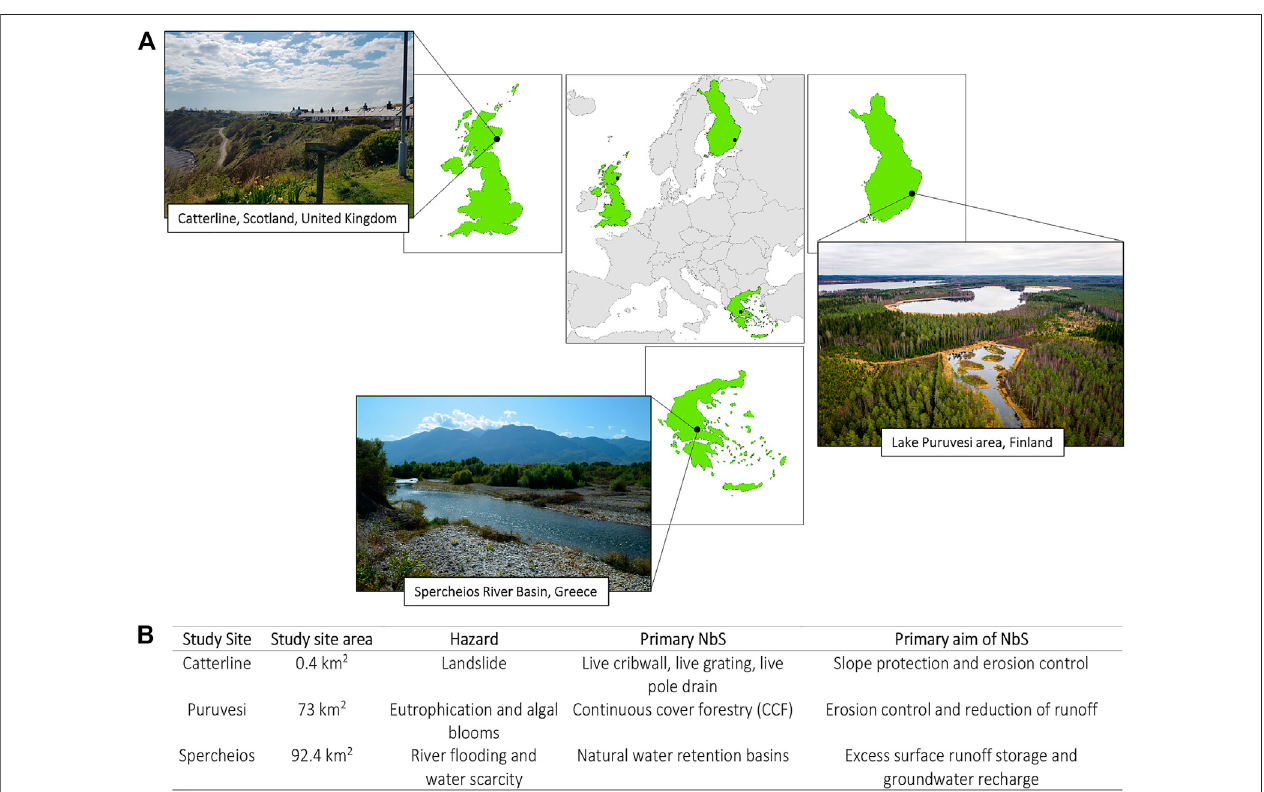
FIGURE 1 | Three European NbS study sites (A) and their characteristics, including hazard type and primary NbS being implemented within the OPERANDUM project (B) . Map: European Commission, Eurostat, https://ec.europa.eu/eurostat/web/gisco/geodata/reference-data/administrative-units-statistical-units/countries. Photo credits: Catterline, Dr Karen Munro; Puruvesi, Pro Puruvesi ry; Spercheios, KKT-ITC S.A.